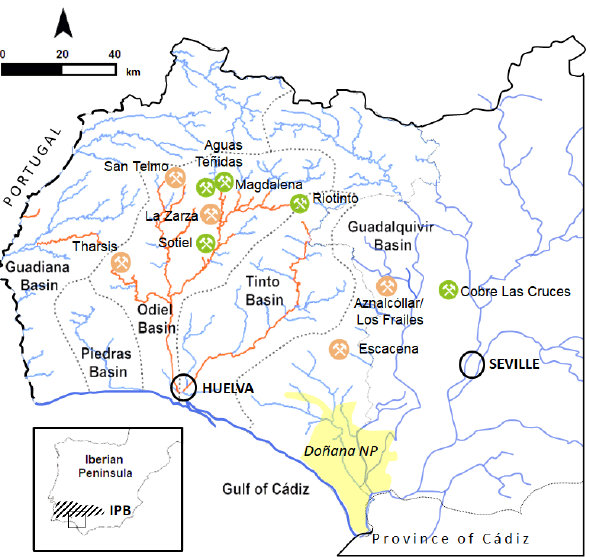
Figure 1. Location of active mines (green) and mines with exploration permission (orange) in Huelva and Seville provinces; and AMD-affected courses in the Odiel-Tinto basin and location of Doñana National Park (yellow).